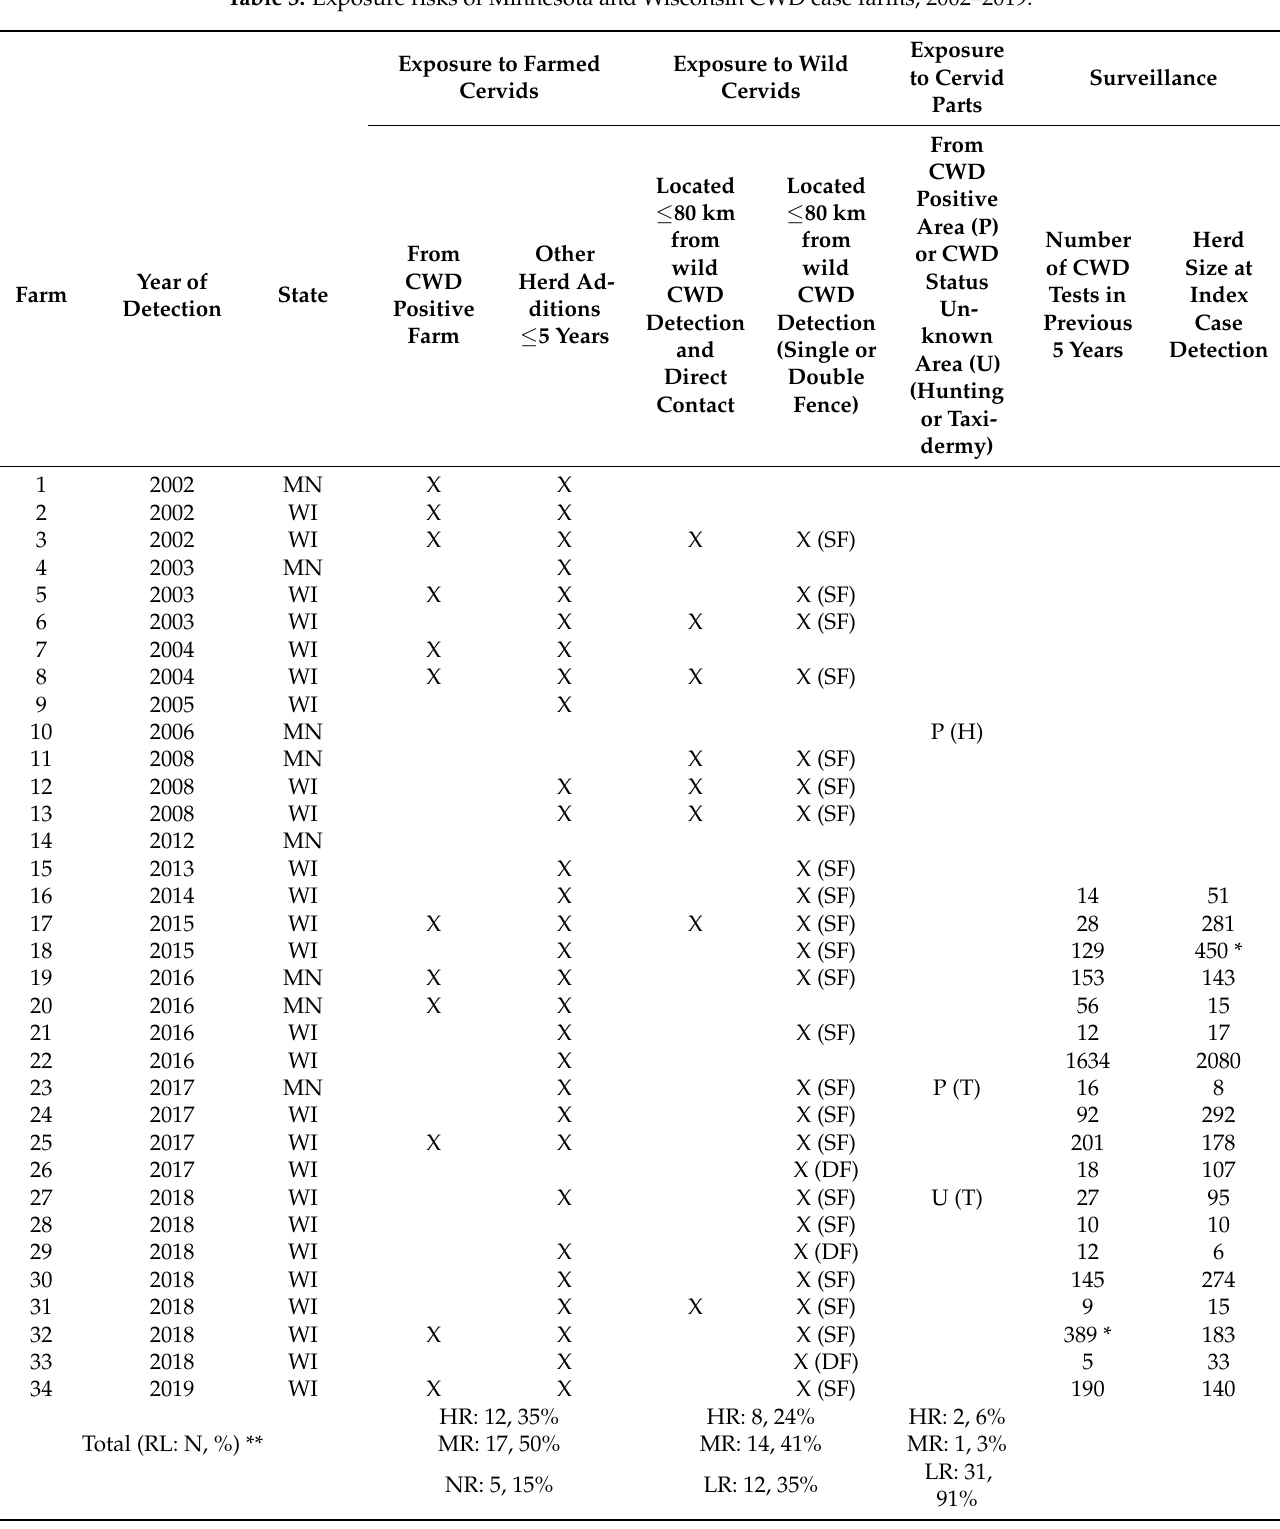
Table 3. Exposure risks of Minnesota and Wisconsin CWD case farms,